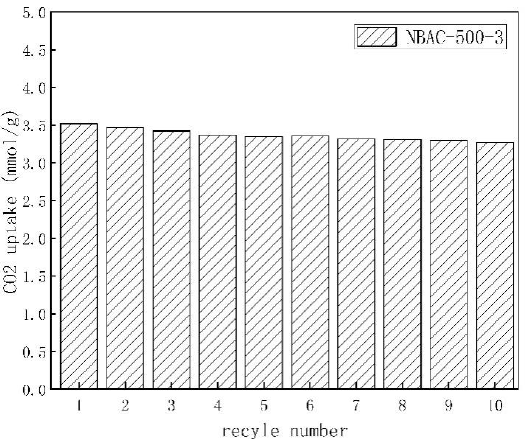
Figure 7. Adsorption/desorption experimental results for NBAC synthesized at 500 °C.